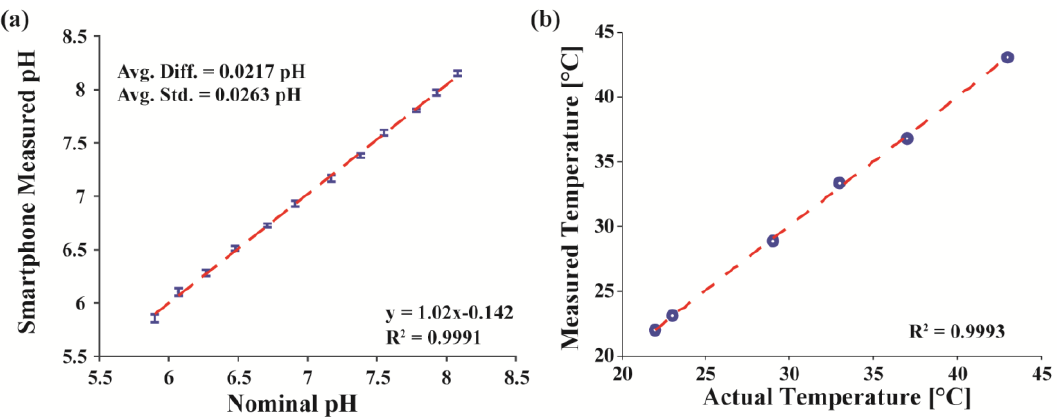
Figure 5. ( a ) Averaged measured pH data taken over one week ( n = 7) for different nominal pH solutions ranging from 5.9 to 8.08 pH. The dotted line is a linear fit of the averaged data; ( b ) Temperature measured by the module compared to actual temperature recorded by a commercial thermometer from 20 to 45 °C.